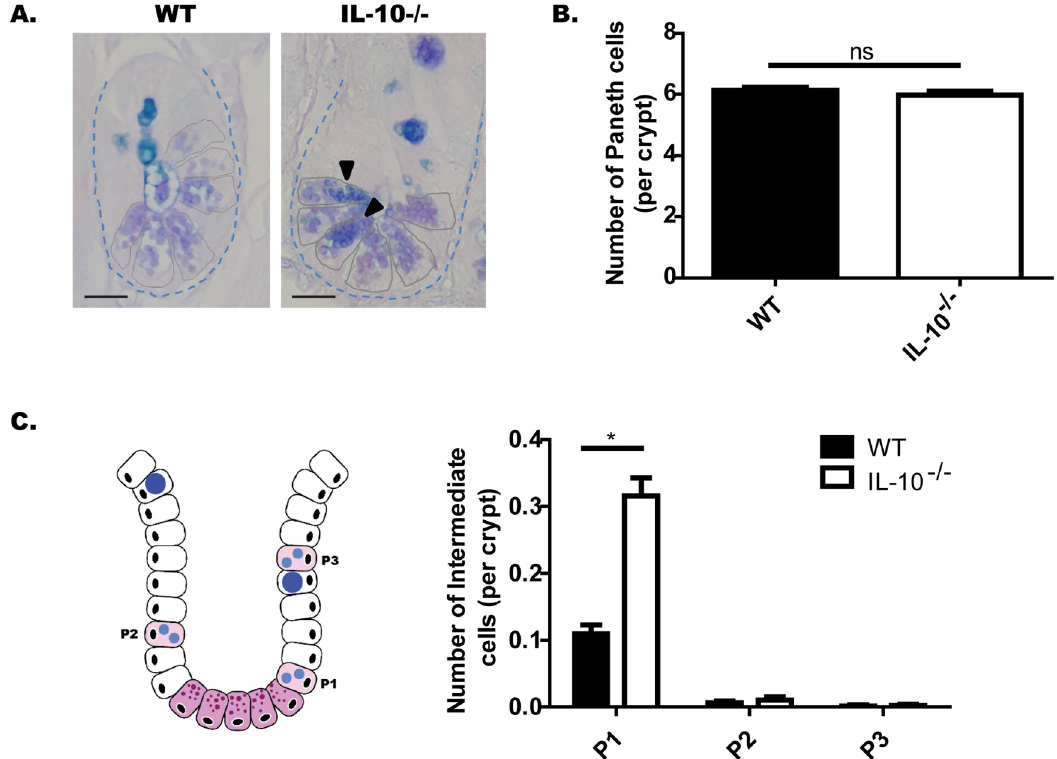
Fig 1. IL-10 -/- mice have more immature Paneth cells at the bottom of the crypt. (A) Representative images of Lieberku¨hn crypts stained with AB-PAS, of C57BL/6 and IL-10 -/- mice. The black arrows show Paneth cells with intermediate cell staining AB+PAS+. Scale bars are 25 μ m. (B) Number of PC per crypt. n = 120 crypts were analyzed from 4 mice. (C) Quantification of Intermediate Cells per crypt of both strains, according to their location: adjacent to Paneth cells (P1), in the middle zone of proliferation (P2), or in upper positions over differentiated Goblet Cells (P3) (2-way ANOVA, post-hoc Bonferroni � p<0.05, ��� p <0.001, n = 660 crypts). (Fig 3A). Using morphometric analysis, it was possible to conclude that IL-10 -/- mice have a higher number of granules per PCs than WT mice (Fig 3B). Although the electron-dense core